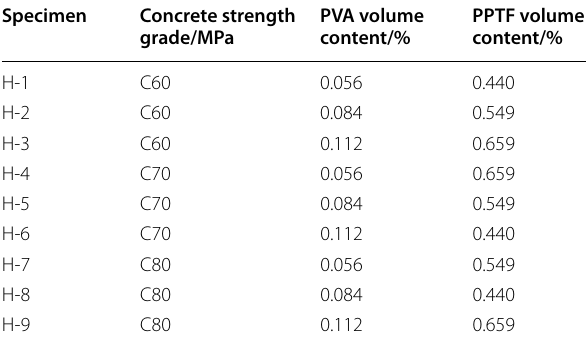
Table 2 Orthogonal test